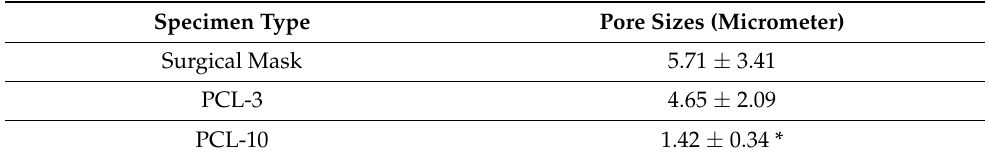
Table 1. Pore analysis on control (middle filter layer of surgical mask), PCL-3, and PCL-10 samples from a SEM image using line intercept method. The pore size is given in mean ± SD. In the table, * represents p < 0.05 compared to control.